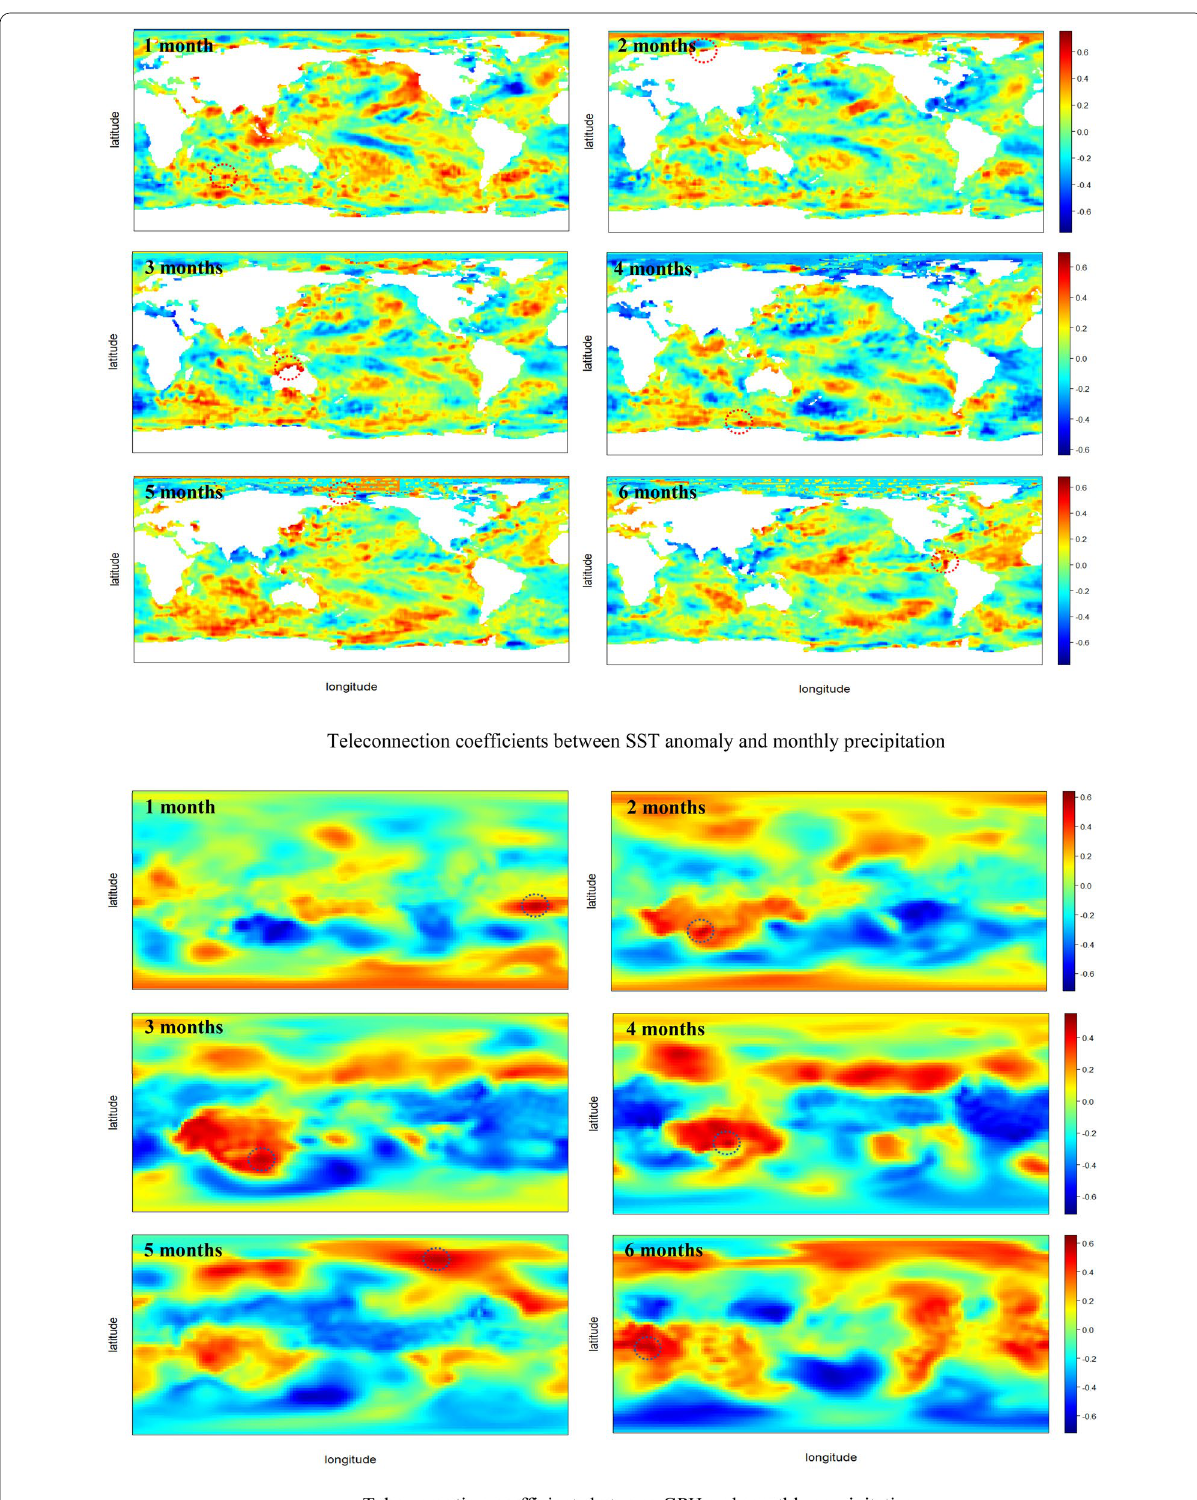
Fig. 26 Teleconnection coefficients between the global-scale climate indices and monthly precipitation during the El Niño